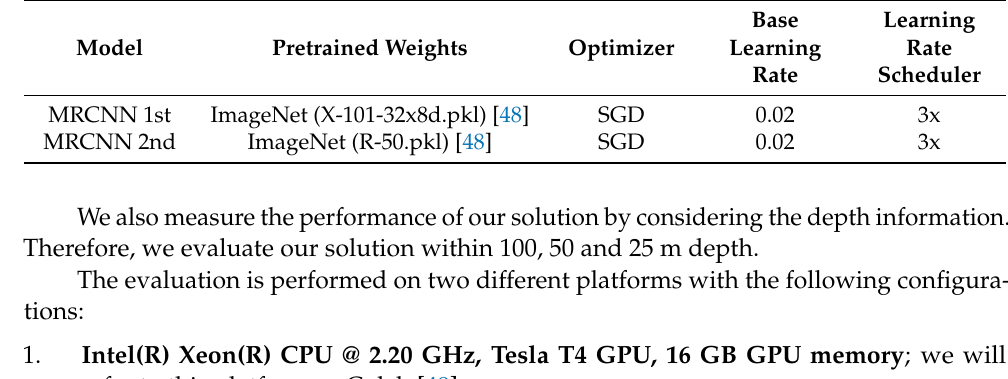
Table 2. Models training configurations